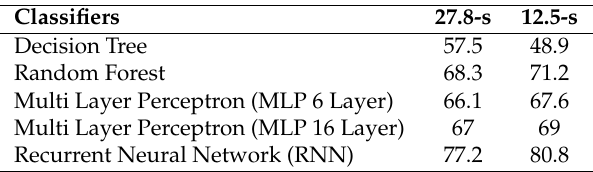
Table 4. Overall Accuracy of 12.5-s and 27.8-s samples.